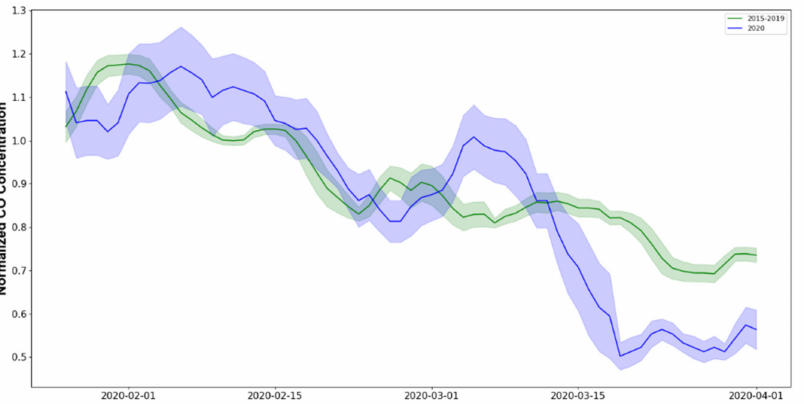
Figure 4. Daily variations in 7-day moving averages of the CO concentration over CA (green represents average CO of past years, purple blue represent CO of 2020, Replicated from